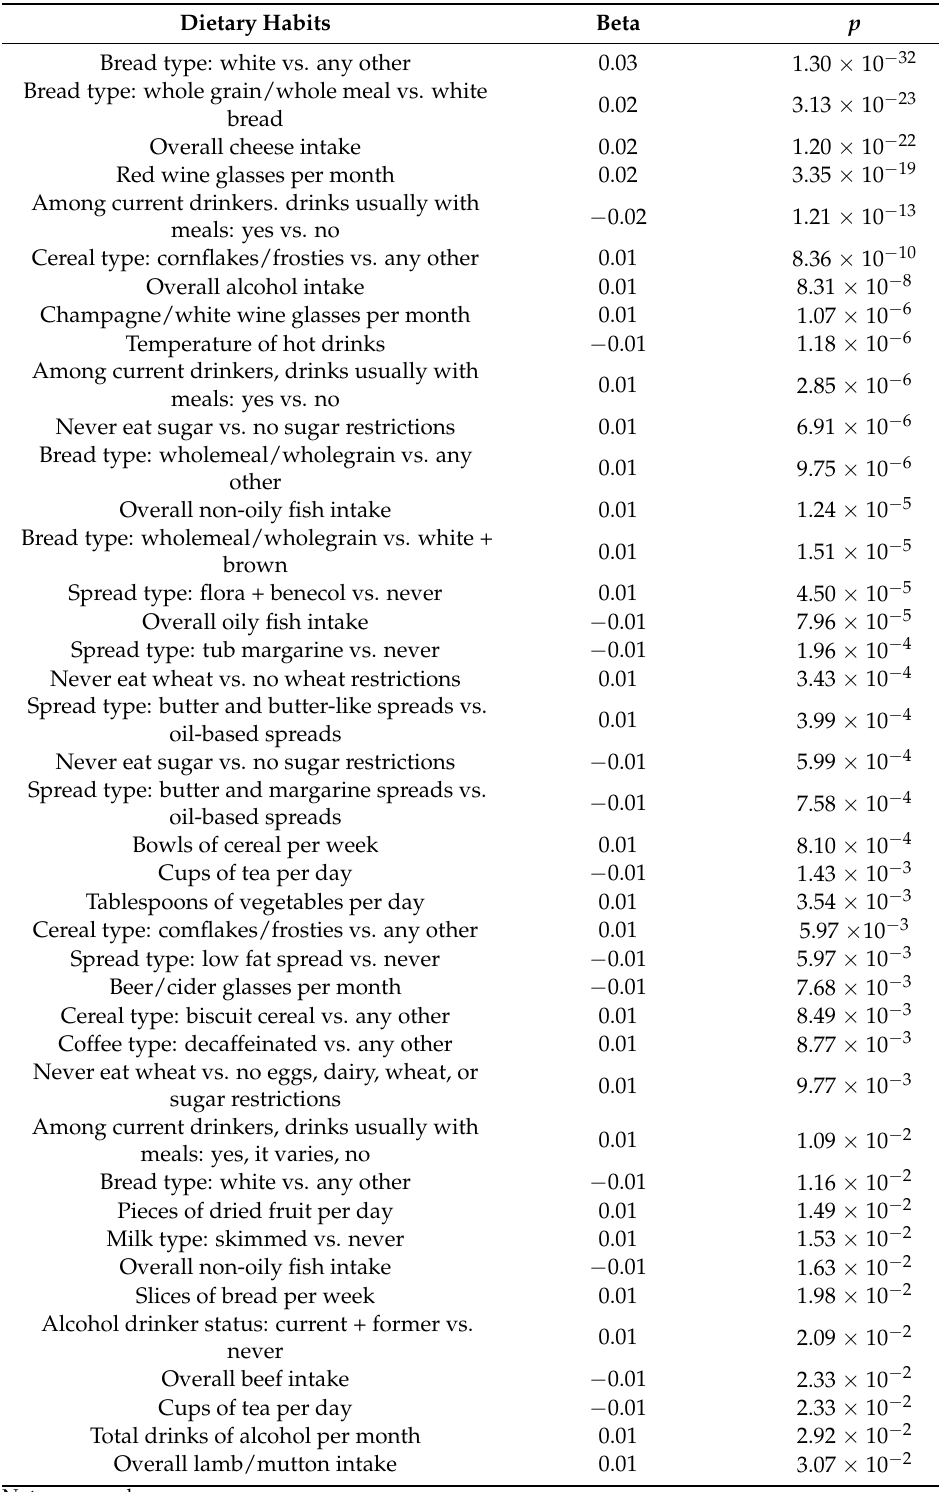
Table A2. The dietary habits associated with intelligence. Dietary Habits Beta p Bread type: white vs. any other 0.03 1.30 × 10 − 32 Bread type: whole grain/whole meal vs. white bread